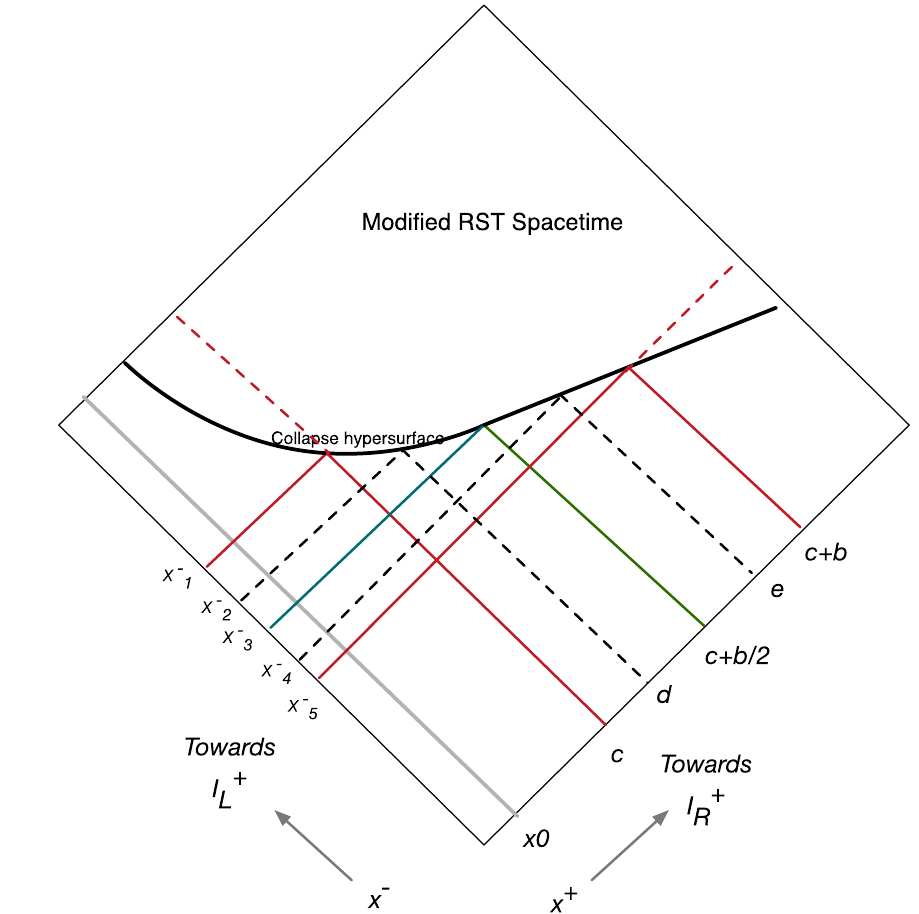
Fig. 4 Modified RST spacetime due to the collapse of wavefunction in Kruskal frame. The energy-momentum tensor due to the collapse of the “in” vacuum state has support in the region c ≤ x + ≤ c + b which modifies the spacetime after the collapse hypersurface. The modification to RST spacetime is the intersection of the future light cone of the point ( x + = c , x − = x − ) and the 1 causal future of all the points on the collapse